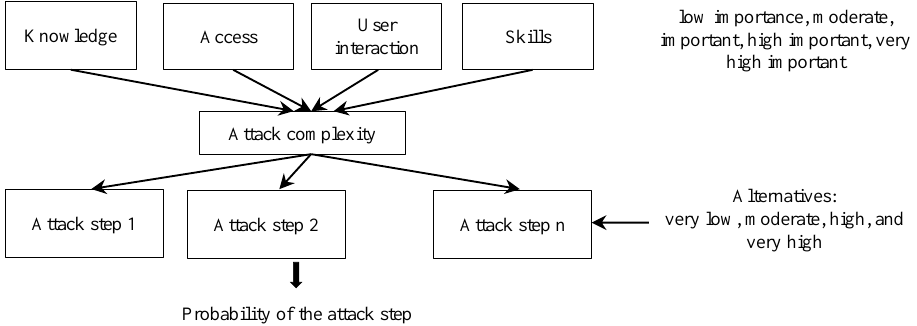
Figure 1. The overall scheme of the approach based on the combination of the attack graph and fuzzy logic.